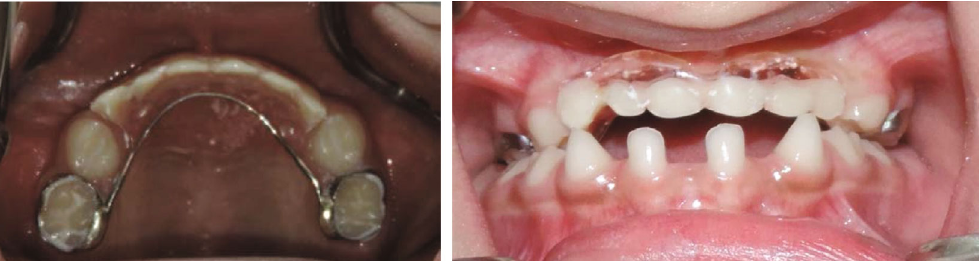
Figure 3: Modi fi ed fi xed Nance appliance with arti fi cial anterior teeth.